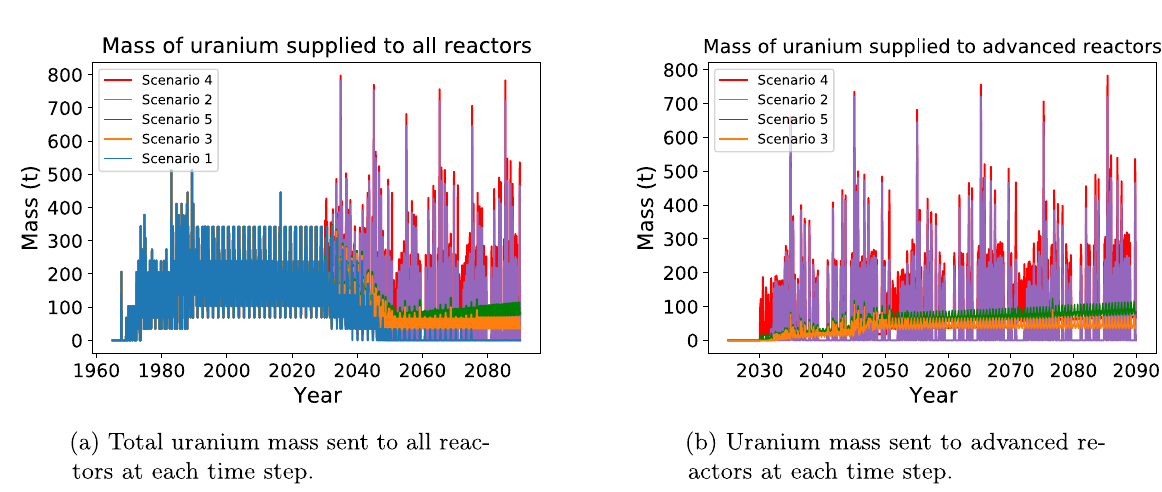
Fig. 17. Uranium mass supplied to reactors in all